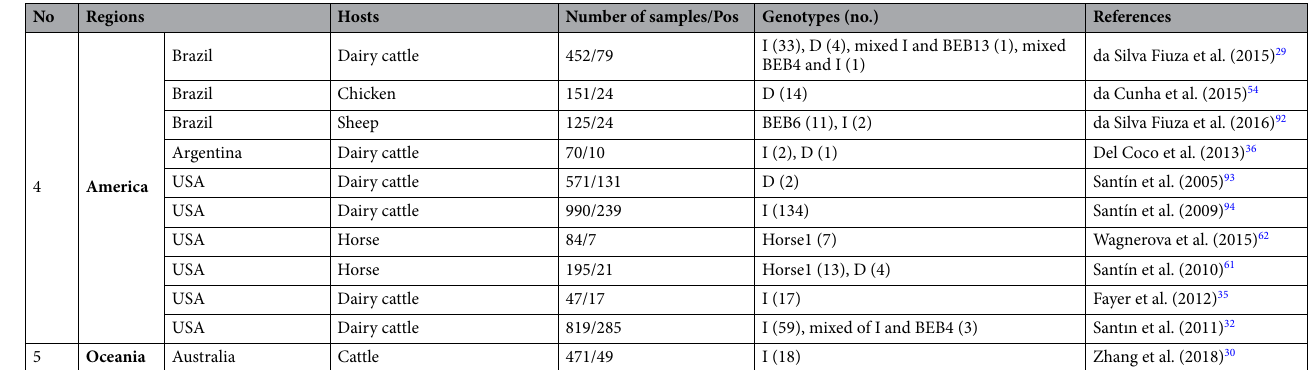
Table 6. A summary of distribution of the genotypes D, BEB6, I, and horse1 from selected studied hosts (sheep, cattle, chicken, and horse) in the world. *Due to lack of access to supplementary tables, the number of the genotype BEB6 is attributed to all E. bieneusi- positive samples. In studies that worked on several hosts, the number of samples, positive samples, and the genotypes were justified based on the only selected hosts (cattle, sheep, chicken, and horse) and investigated